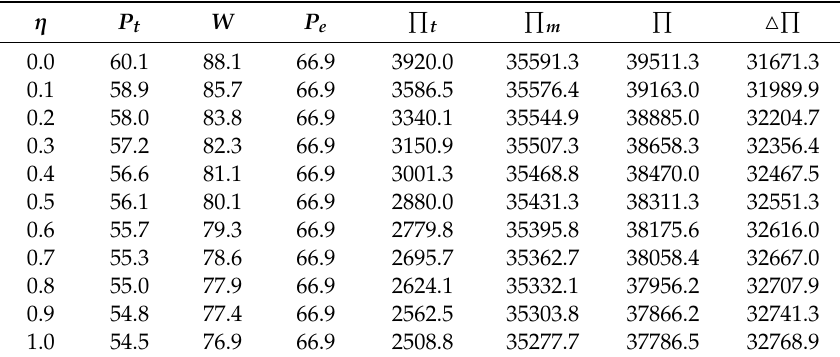
Table 3. The e ff ect of η on decisions and